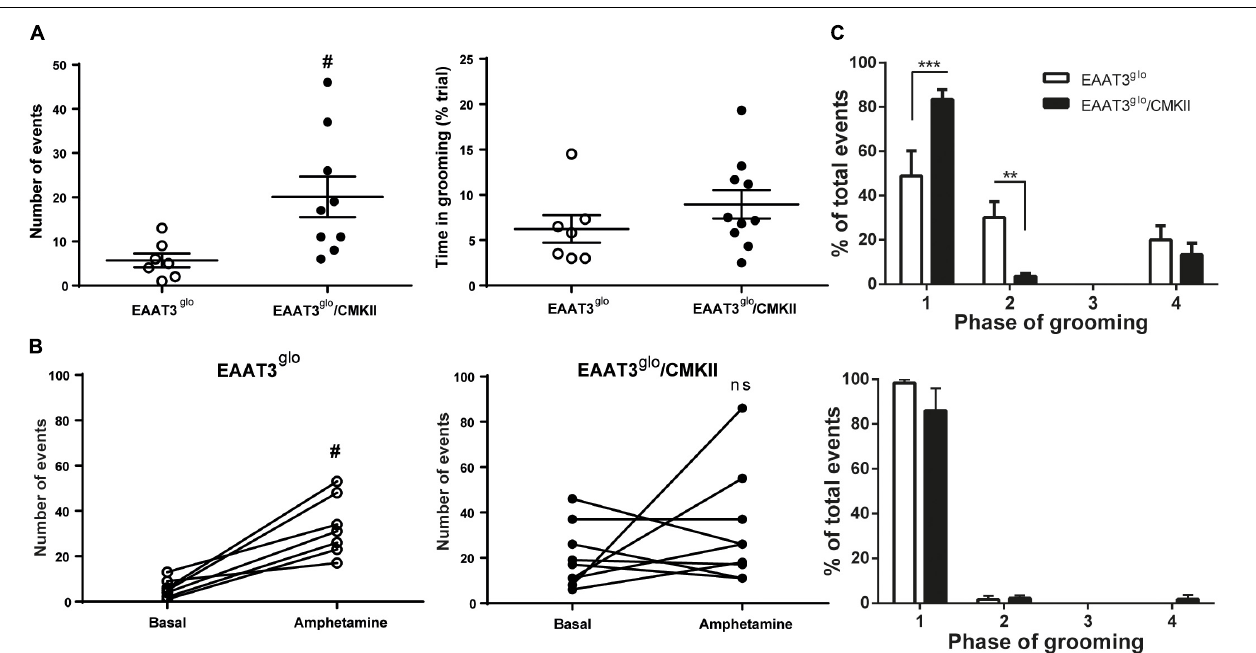
FIGURE 1 | Grooming behavior is increased and its chain syntax altered in EAAT3 glo /CMKII mice. Mice were placed in a cylindrical transparent plexiglass container, and its grooming behavior was video recorded for 10 min in basal conditions and after an acute injection of amphetamine [5 mg/kg subcutaneously (s.c.)]. Analysis of grooming was made by an experimenter blind to the genotype of the mice. (A) Comparison of grooming behavior between EAAT3 glo and EAAT3 glo /CMKII mice in basal conditions. (B) Number of grooming events in basal conditions paired with the number of grooming events after acute administration of amphetamine in EAAT3 glo (left) and EAAT3 glo /CMKII (right) mice. (C) Distribution of grooming events in the phases of the grooming-chain syntax in basal (upper panel) and after amphetamine administration (lower panel). EAAT3 glo n = 7 (4M, 3F); EAAT3 glo /CMKII n = 9 (3M, 6F). ** p < 0.01, *** p > 0.001, according to two-way ANOVA and Sidak’s multiple comparison test. # p = 0.0187, according to unpaired t